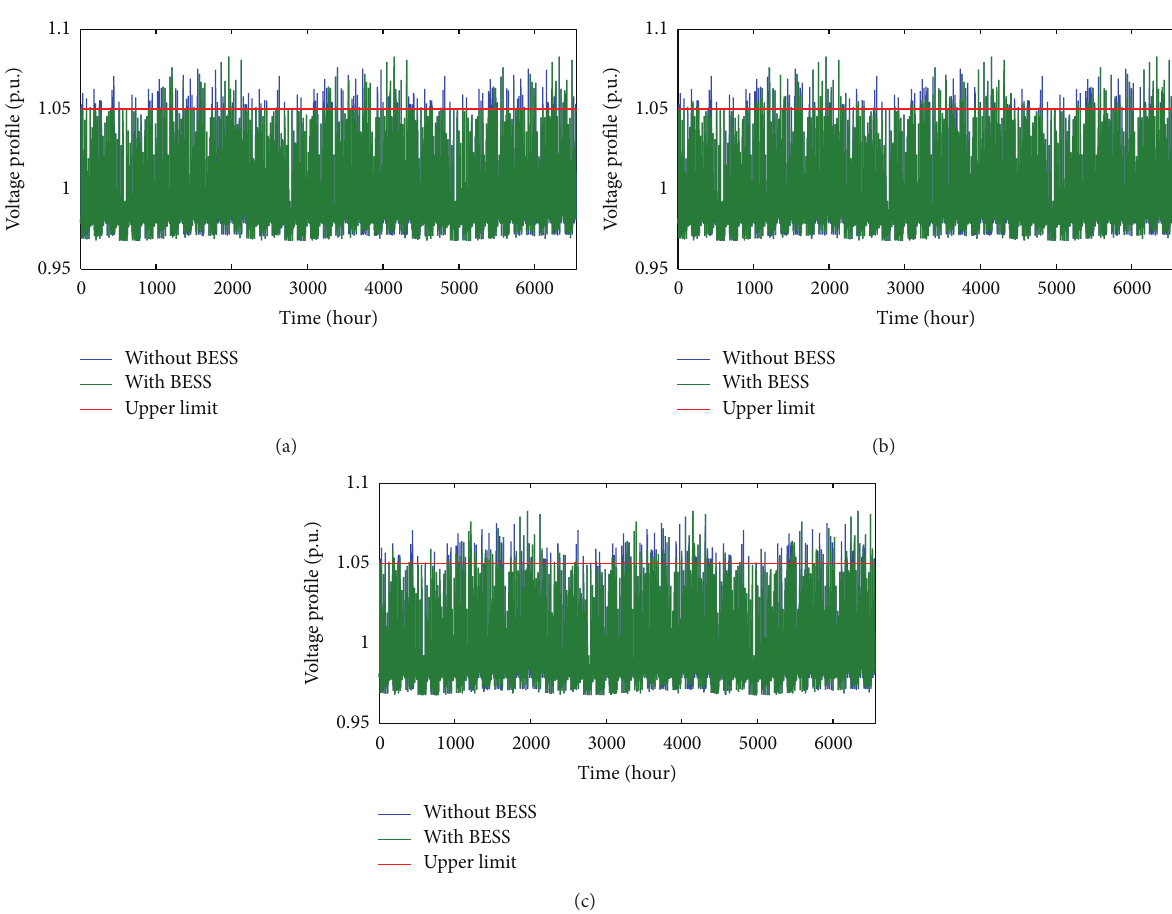
Figure 10: Comparison of voltage profile with and without optimal BESS size obtained with (a) EOFA, (b) FA, and (c)